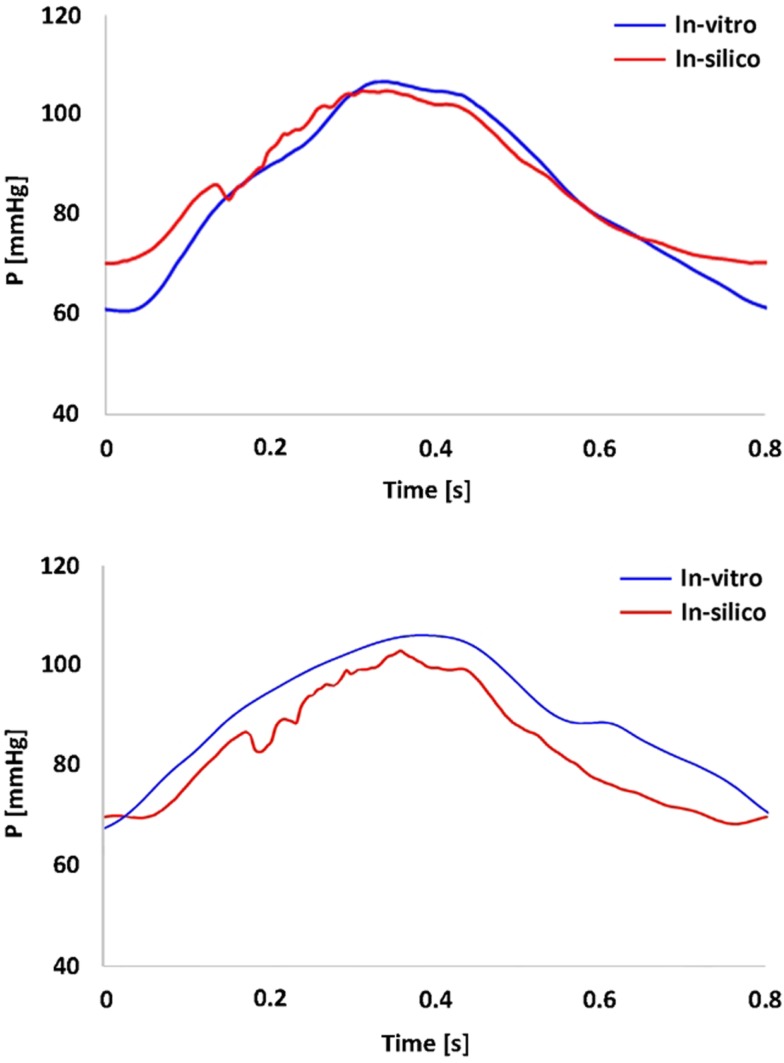
Summary of pressure data showing the realistic shape and range of the pressure waveform gathered in the TGA model (top panel) and in the control model (bottom panel). In vitro (blue) and in silico (red) signals are superimposed.